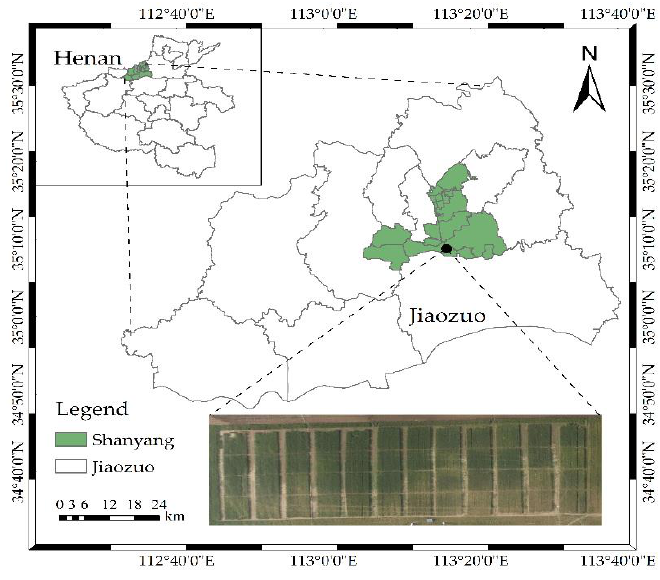
Figure 1. The schematic of the study